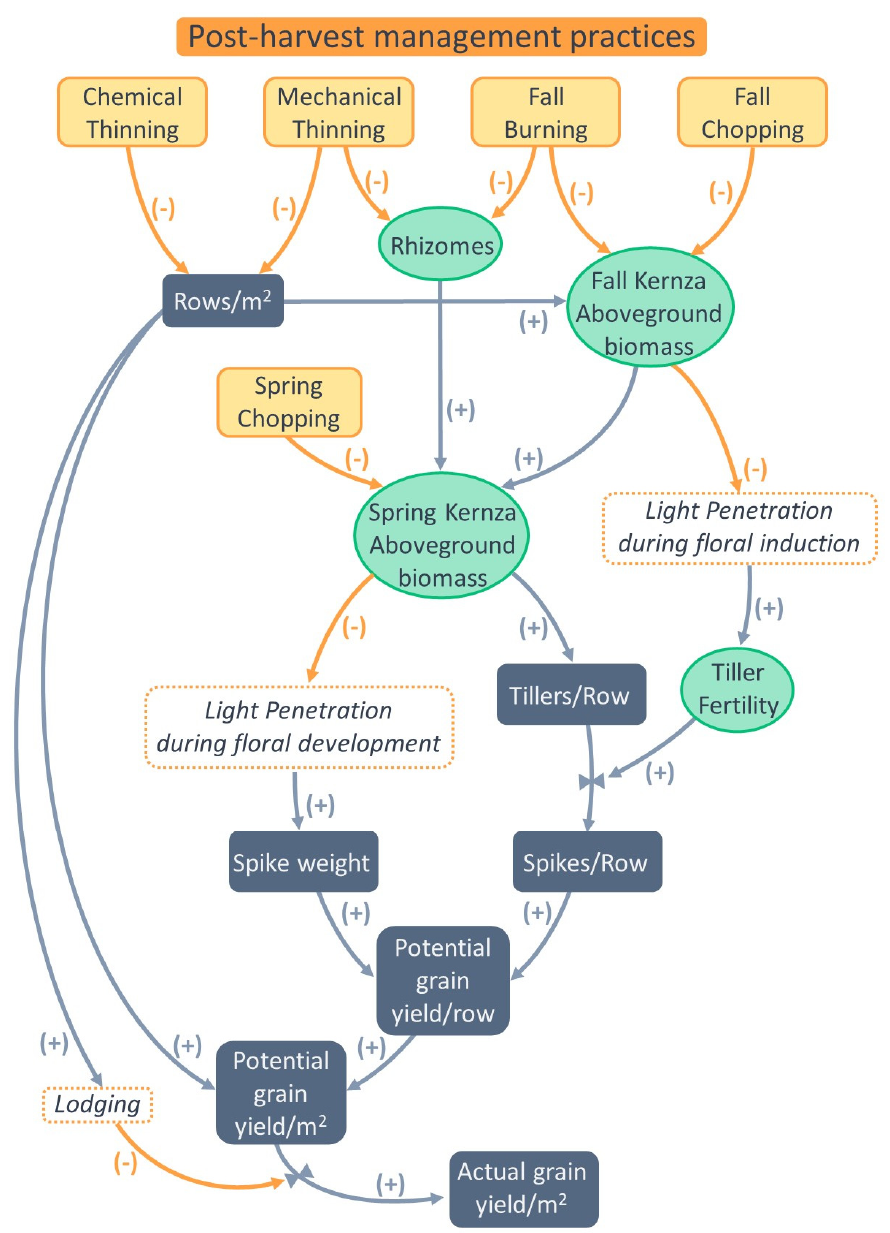
Figure 4. Conceptual model proposed to explain how different post-harvest management practices modified the components of Kernza grain yield in this experiment. The orange boxes represent the post-harvest management practices considered: chemical and mechanical thinning, fall burning, fall chopping and spring chopping. The blue boxes represent the yield components. The arrows show the effect each box has on other, blue arrows are positive effects (+) and orange arrows are negative effects (-). Therefore, if one box has a negative effect on other box which has a positive effect on a third, the first have a negative effect on the third. The bows in the arrows indicate proportions that are affected.